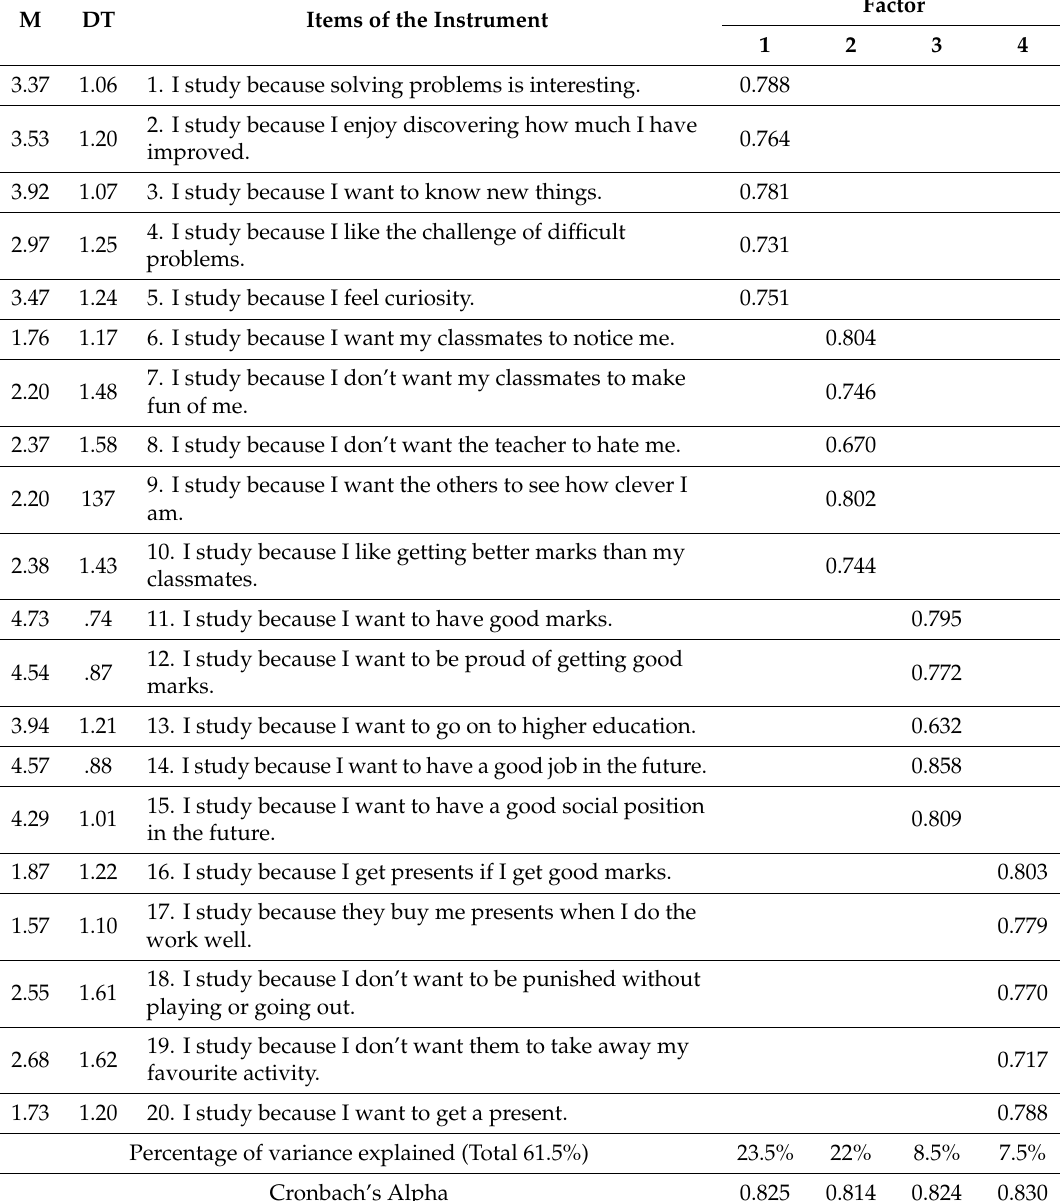
Table 1. Factorial analysis of the instrument: Principal components with Oblim í n